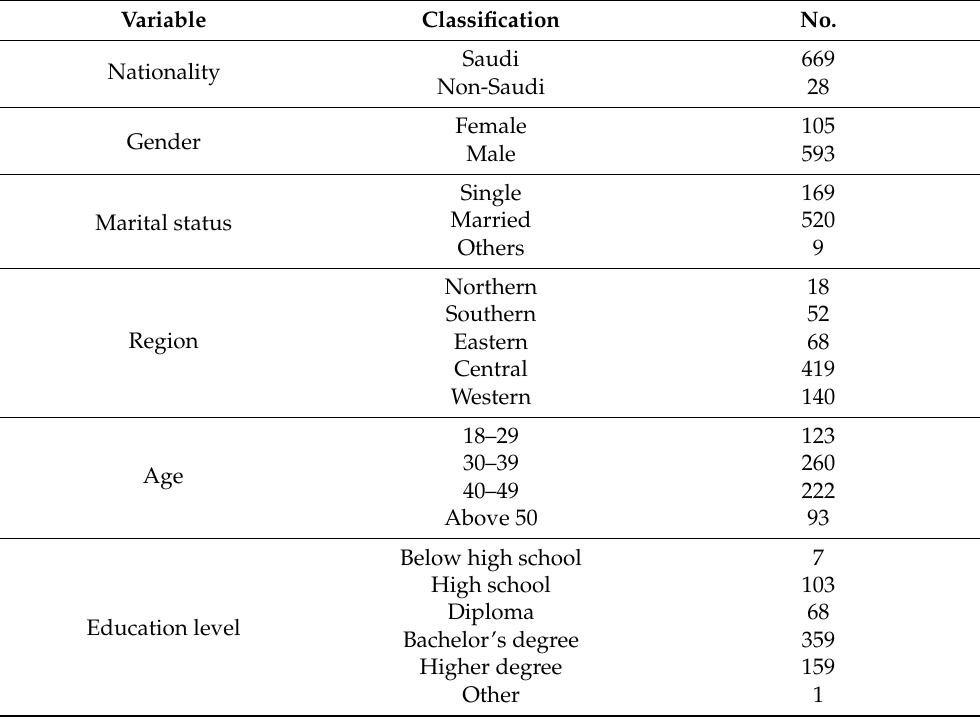
Table 7. Demographic data on survey